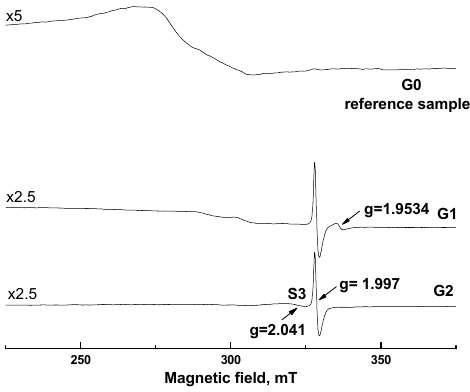
Figure 8. EPR spectra of plant-mediated ZnO powders.